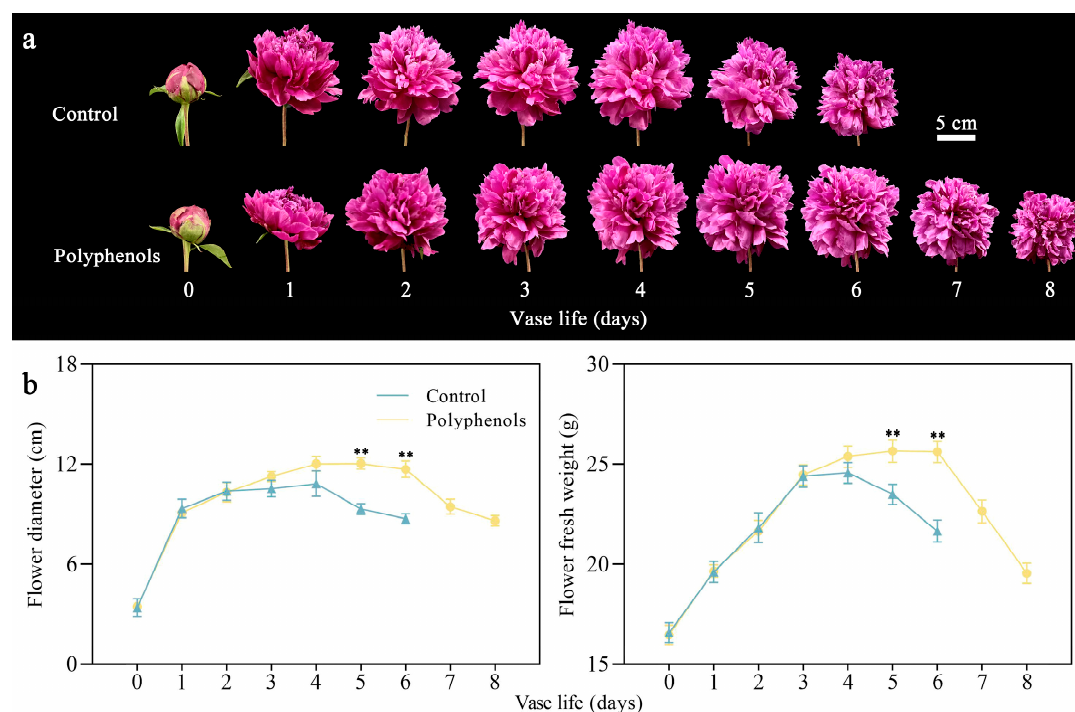
Figure 1. Effect of polyphenols on morphological indices of cut herbaceous peony flowers. ( a ) Effect of polyphenols on the vase performance of cut herbaceous peony flowers during the vase life. ( b ) Effect of polyphenols on the flower diameter and fresh weight of cut herbaceous peony flowers during the vase life. ** indicates highly significant difference of data, p < 0.01. Same below.